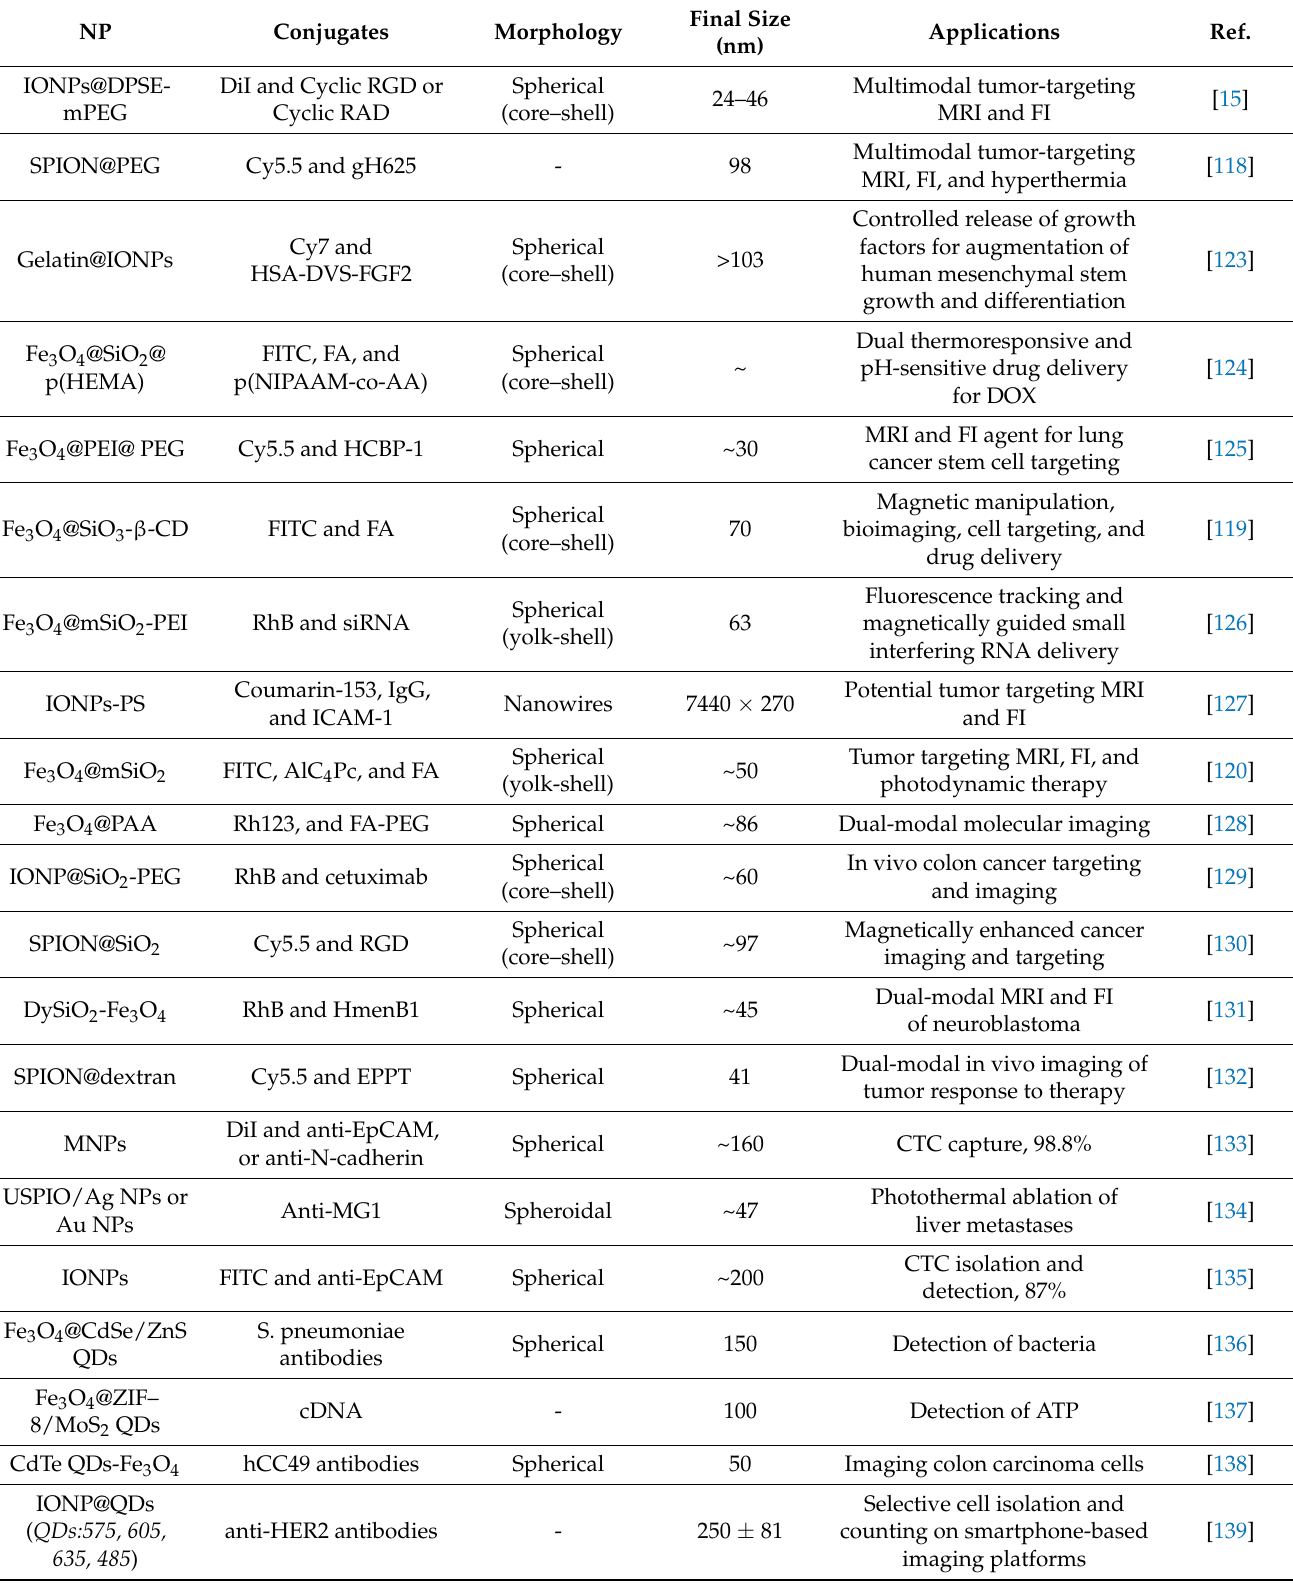
Table 6. Multiconjugate integrated magnetic nanoparticles for biomedical